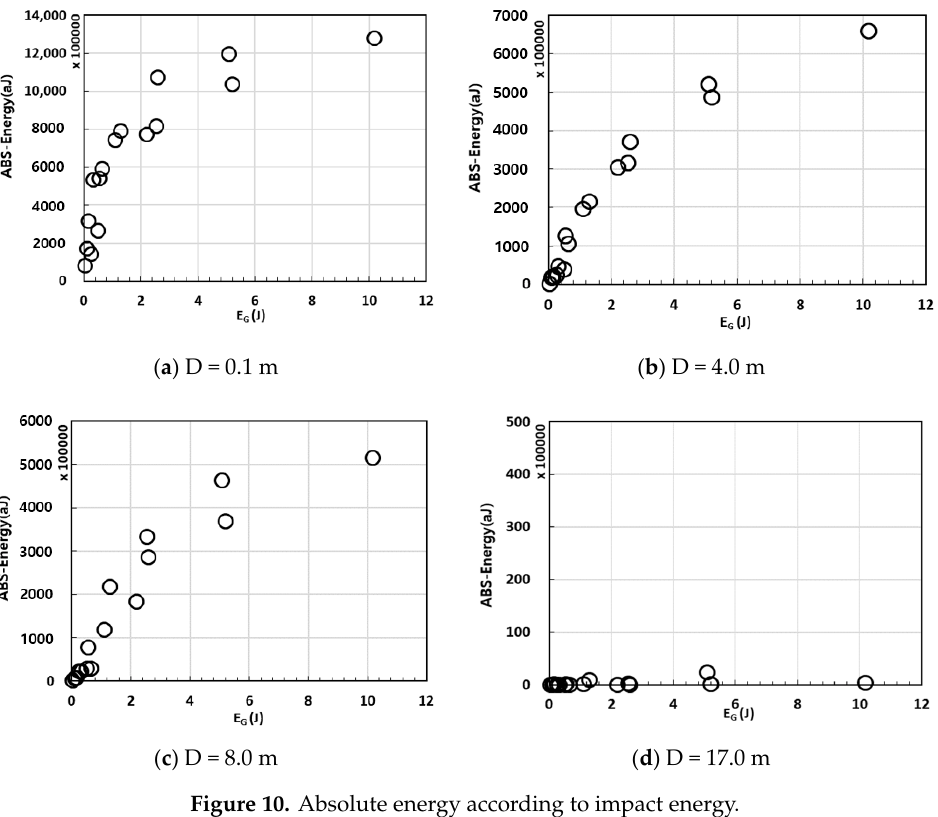
Figure 10. Absolute energy according to impact energy.